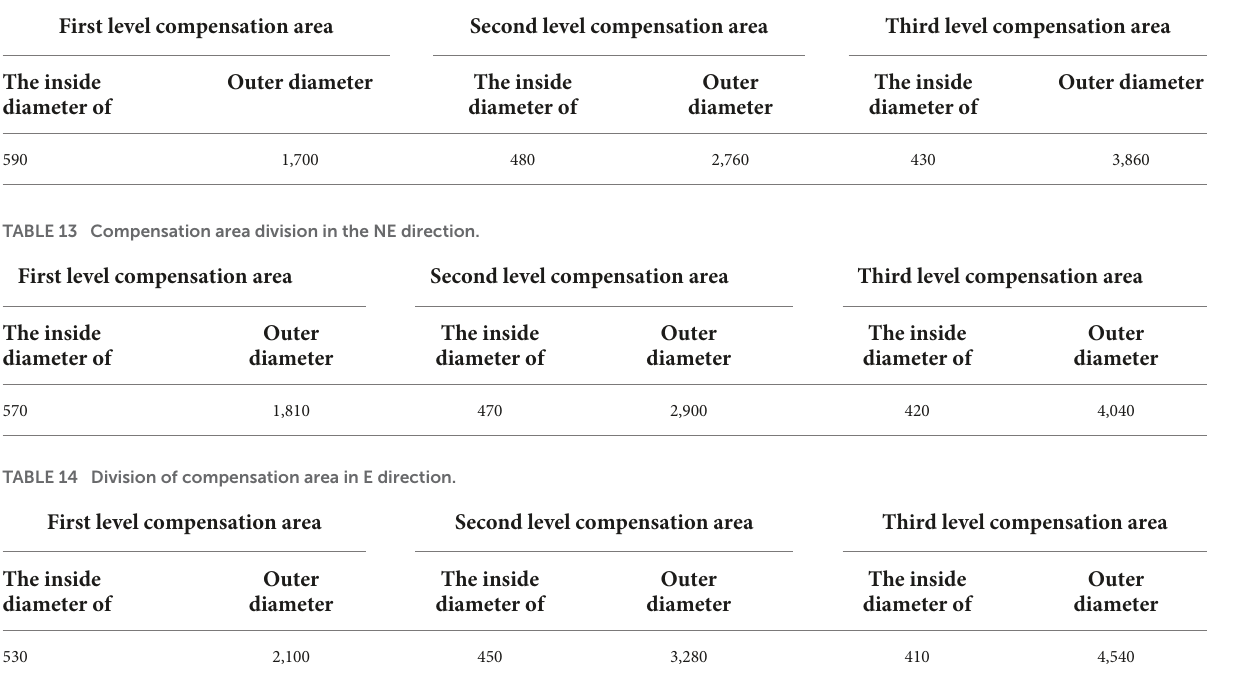
TABLE 12 Division of compensation regions in the N direction.